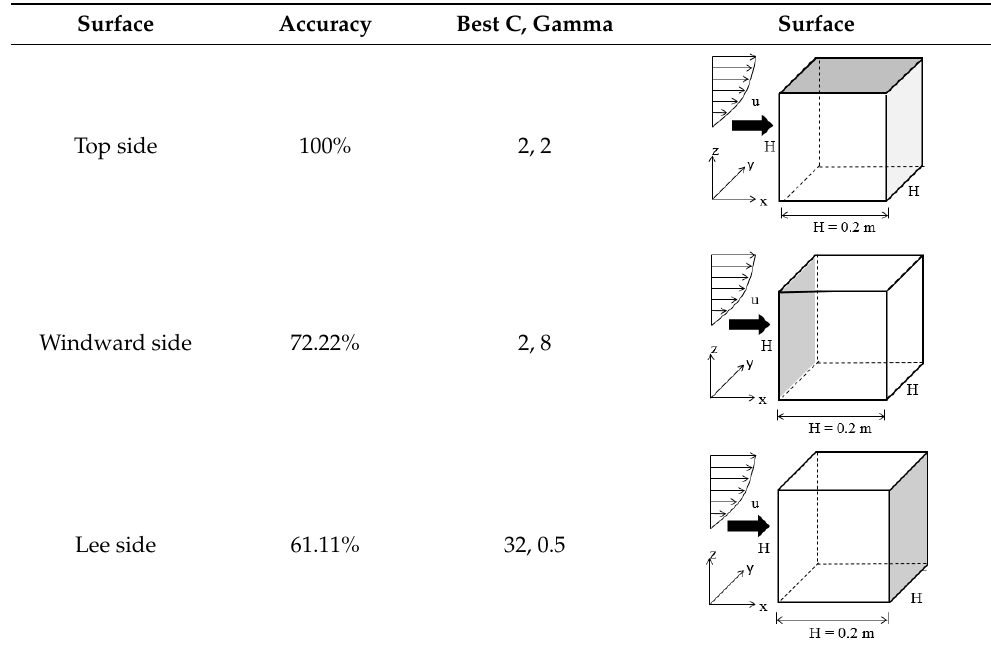
Table 6. SVM fitting models under the 0° wind direction condition.